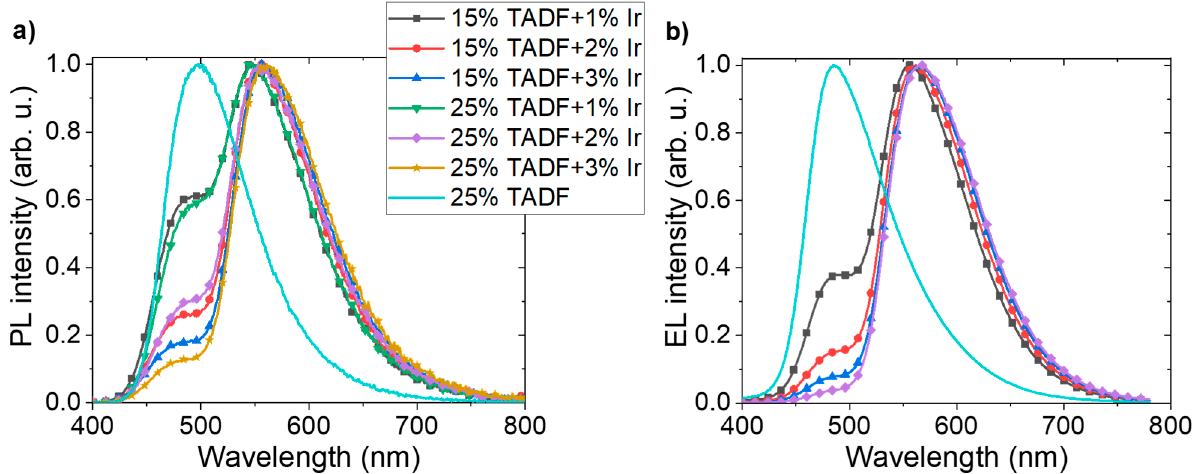
Figure 4. ( a ) PL spectra of PVK layers with different SpiroAC–TRZ (15 or 25 wt%) and Ir complex (Ir) (1–3 wt%) concentrations; ( b ) EL spectra of OLEDs based on the investigated systems. OLED configuration: ITO/PEDOT:PSS (20 nm)/LEL (70 nm)/TPBi (20 nm)/Liq (2 nm)/Ag (100 nm).